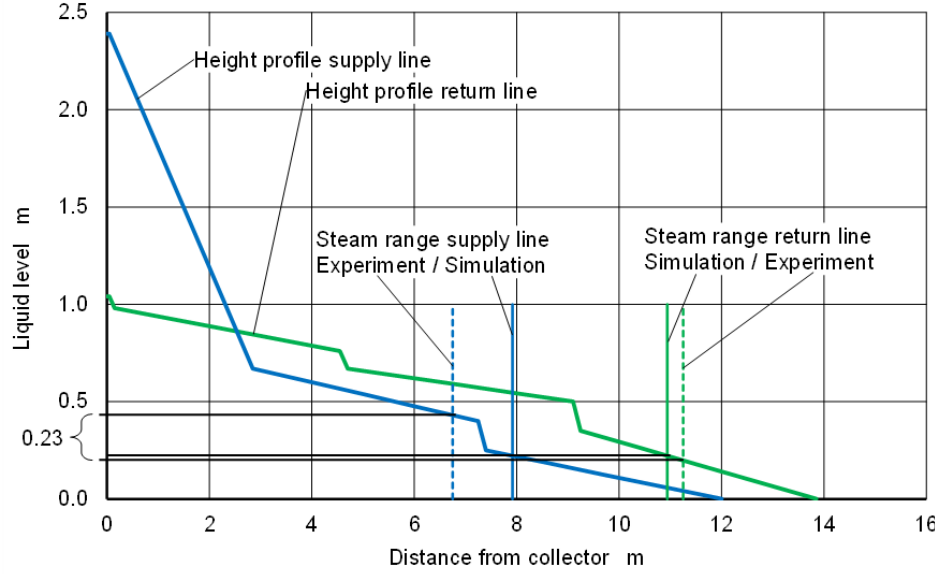
Figure 11. Height profiles of the supply and return lines.